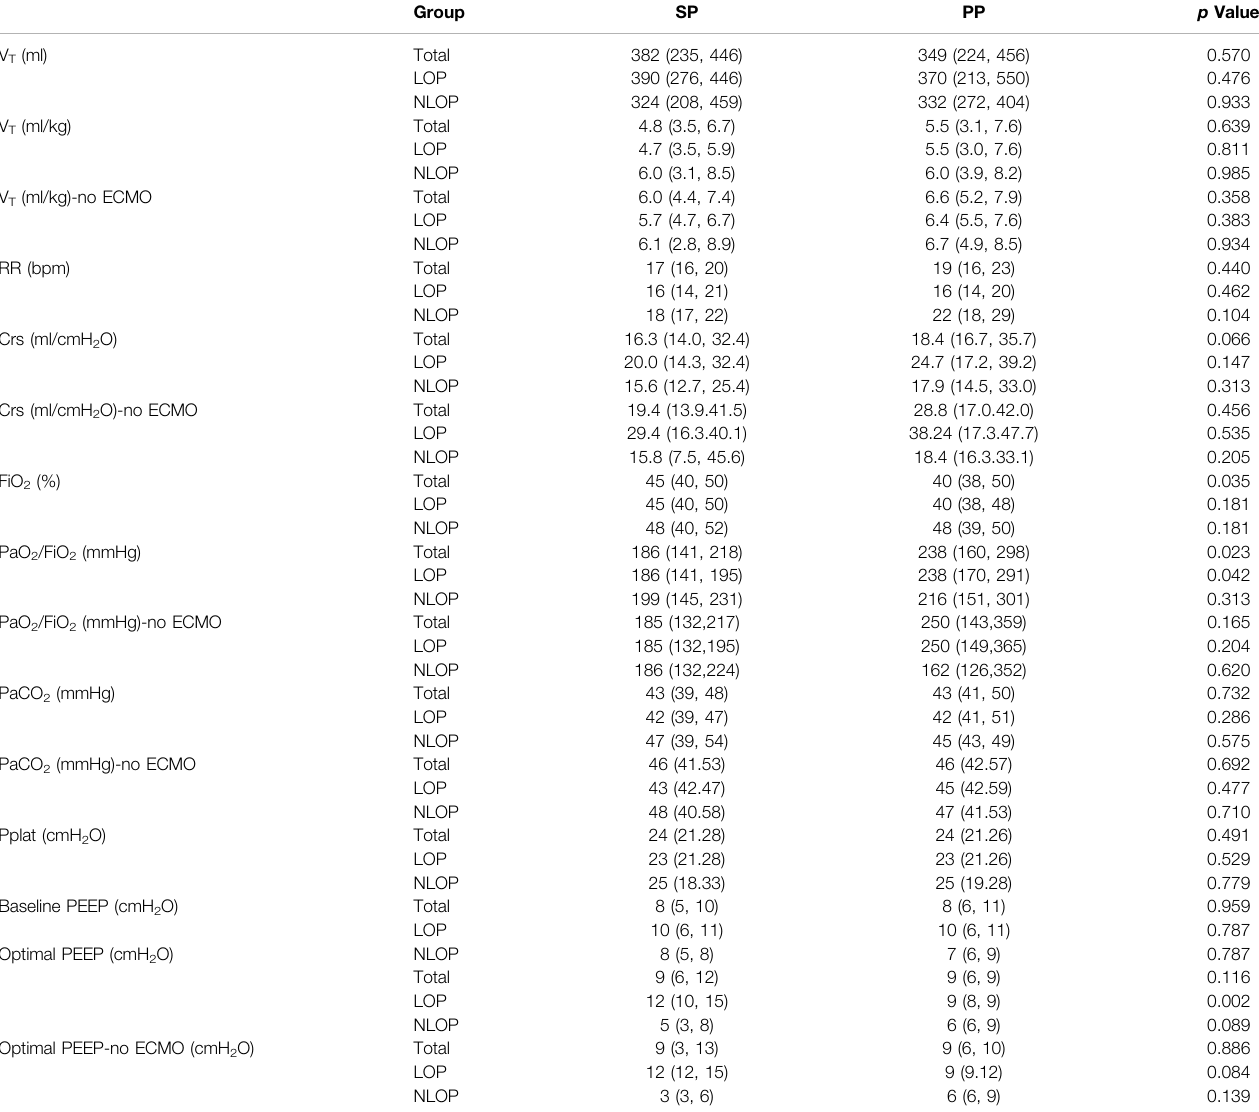
TABLE 2 | Difference of ventilator parameters at supine position and prone position. Group SP PP p Value V T